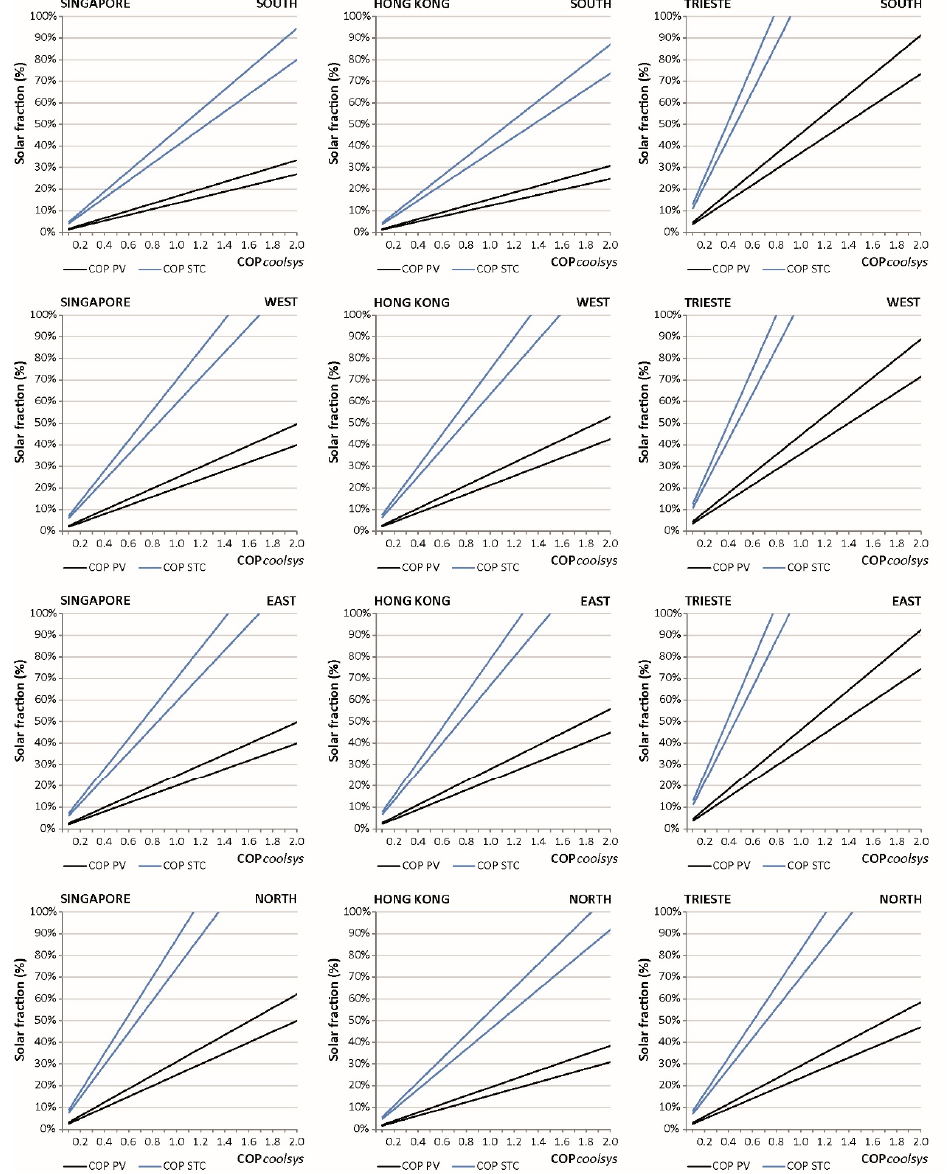
Figure 3. Comparison between solar fraction and COP (electric and thermal) of a given solar cooling system in warm, humid climates.